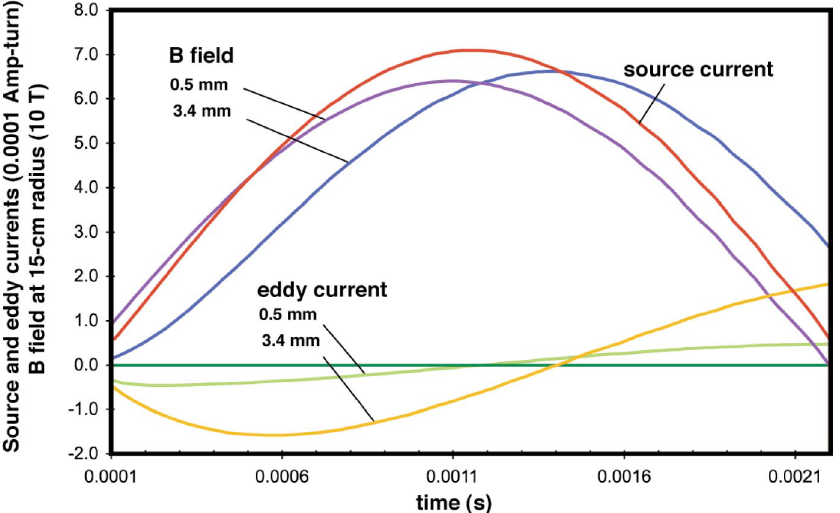
FIG. 18. (Color) NTX beam-pipe eddy currents and magnetic fields from a 2D finite-element analysis. The linear dimensions indicate the beam-pipe thickness.